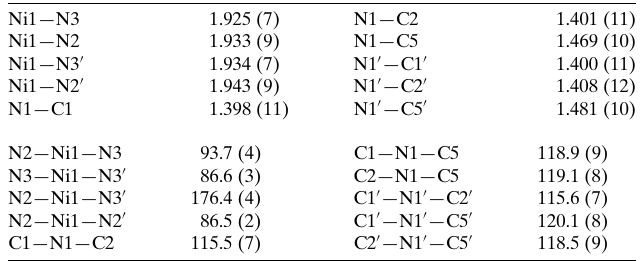
Table 1 Selected geometric parameters (A˚ , (cid:2) ).